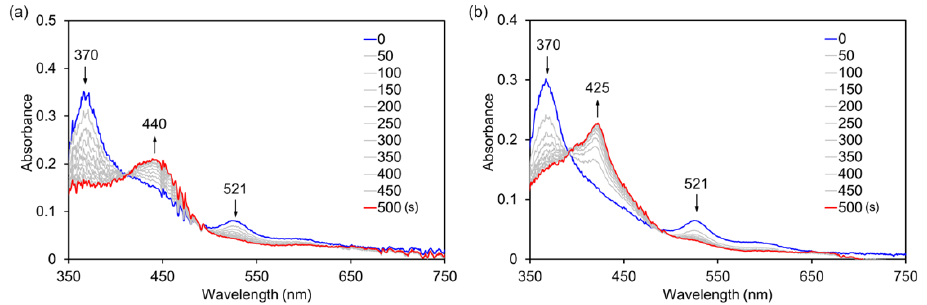
Figure 9. UV-vis spectral changes of rMb(Co III Cor) upon addition of H 2 O 2 without guaiacol ( a ) and with guaiacol ( b ). [rMb(Co III Cor)] = 8 μM, [H 2 O 2 ] = 10 mM, [guaiacol] = 10 mM in 100 mM potassium phosphate buffer (pH 7.0), 25 °C.